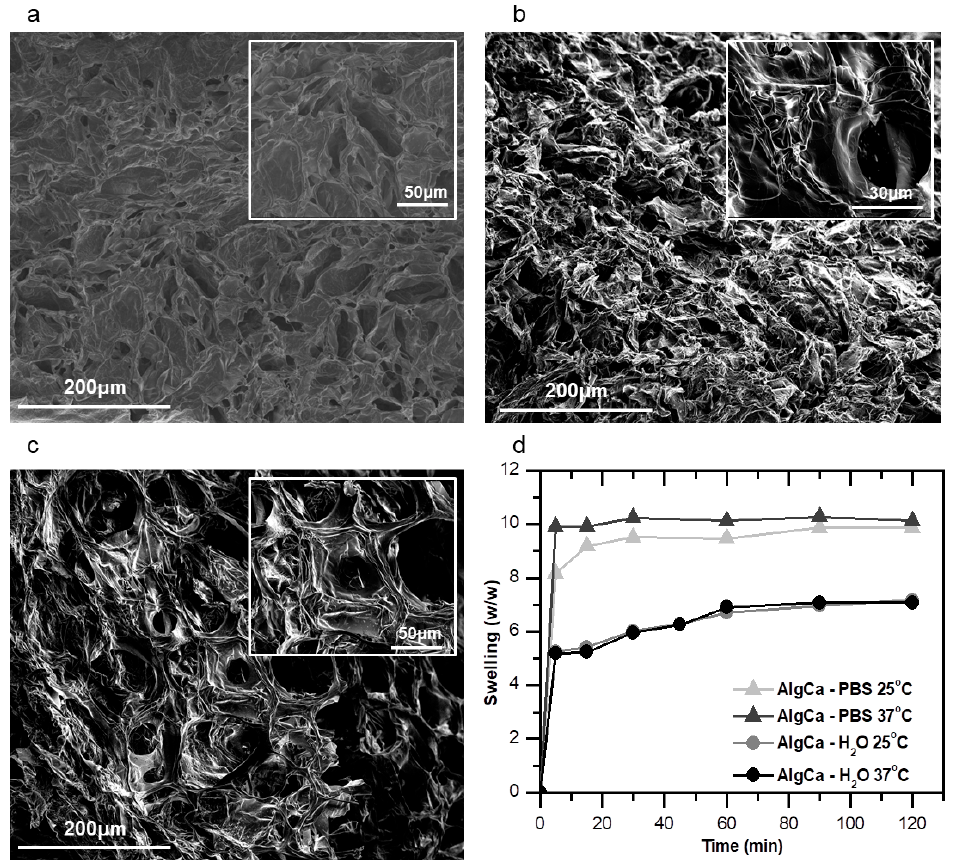
Figure 3. SEM images of the cross-section of crosslinked gels. ( a ) Pure alginate (AlgCa); ( b ) alginate-CNCT gel at 50 wt %; and ( c ) alginate-CNFT gel at 50 wt % of nanocelluloses; 500× magnification ( a – c ). The insets represent magnification of 1500× ( a , c ) and 3500× ( b ); ( d ) swelling kinetics of the calcium crosslinked alginate-gel (AlgCa). Table 2. Maximum moisture uptake after swelling tests during 2 h at 37 °C in milli-Q water pH 6.2 and in PBS pH 7.4 for the pure alginate gels and alginate-nanocellulose gels. Moisture Uptake (g/g) Sample Milli-Q H 2 O; pH 6.2